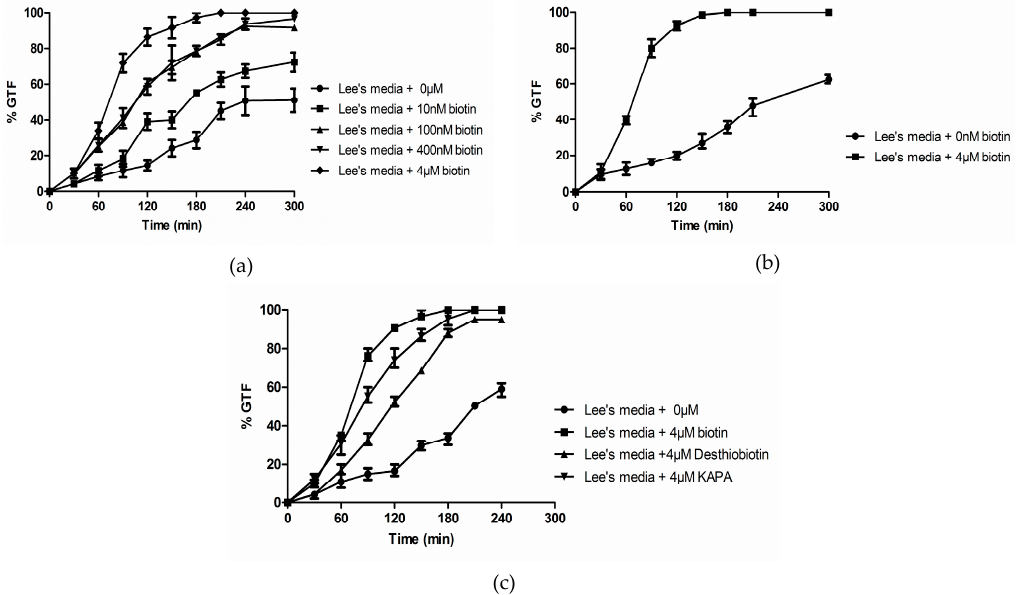
Figure 3. The germ tube formation (GTF) assays were conducted in Lee’s media containing variable levels of biotin at 37 ° C with rotary agitation at 220 rpm. Cultures were observed for 4 to 5 h. ( a ) Dose-response for biotin. Symbols: , no addition; , 10 nM biotin; , 100 nM biotin; ▼ , 400 nM biotin; and , 4 µM biotin. ( b ) GTF assays in Lee’s Medium prepared without L-proline. Symbols: , no addition; and , 4 µM biotin. ( c ) Desthiobiotin and KAPA also stimulate GTF. , no addition; , 4 µM biotin; , 4 µM desthiobiotin; and ▼ , 4 µM KAPA. Values shown are the average of triplicate experiments ± SD.